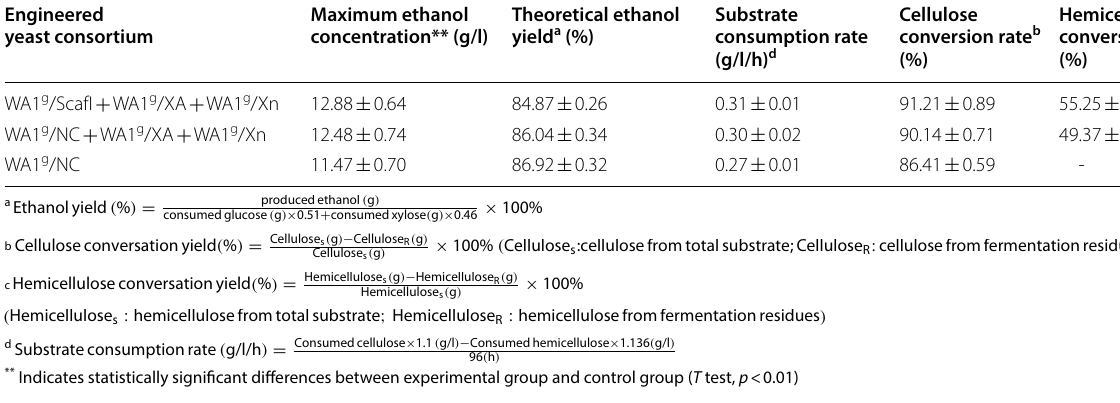
Table 4 Summaries of SSCF performance of engineered yeast consortium